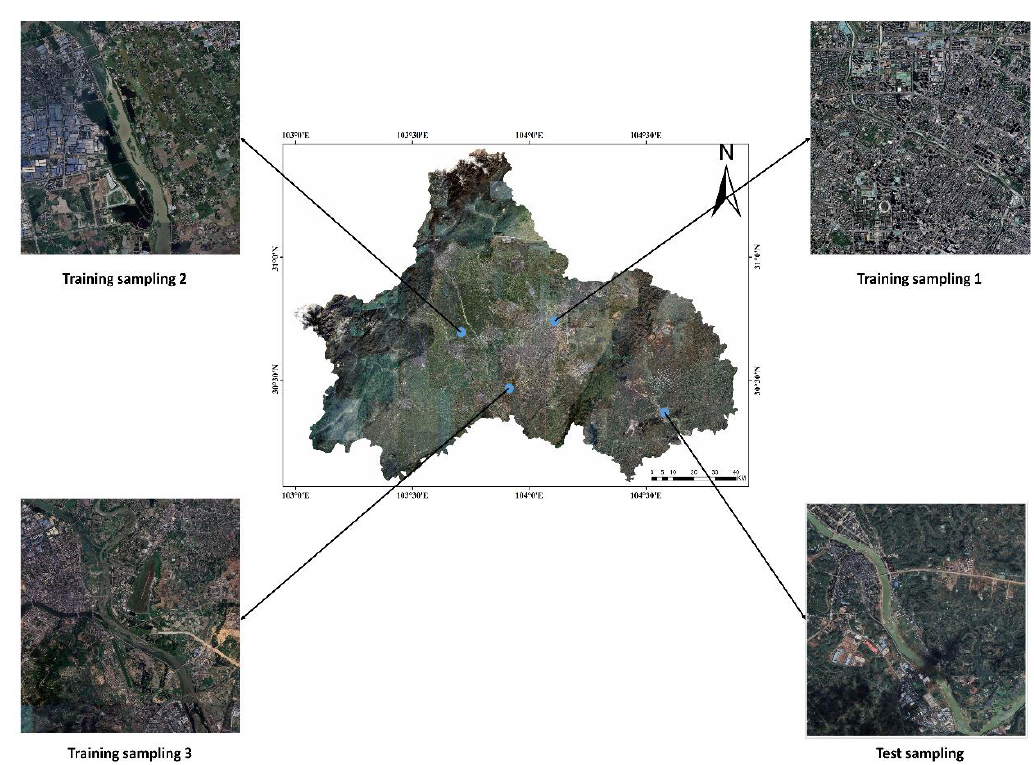
Figure 2. Training and test sample selection location and remote sensing image.